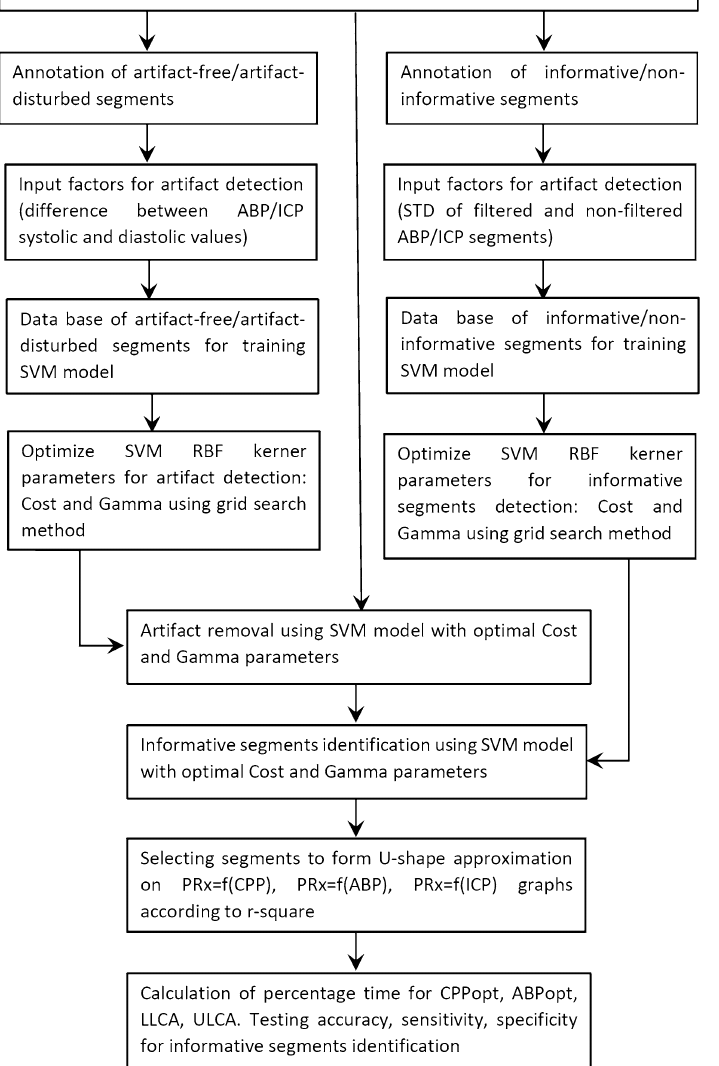
Figure 3. Workflow diagram of multimodal monitoring data analysis using ML models for CPPopt, ABPopt, LLCA, and ULCA